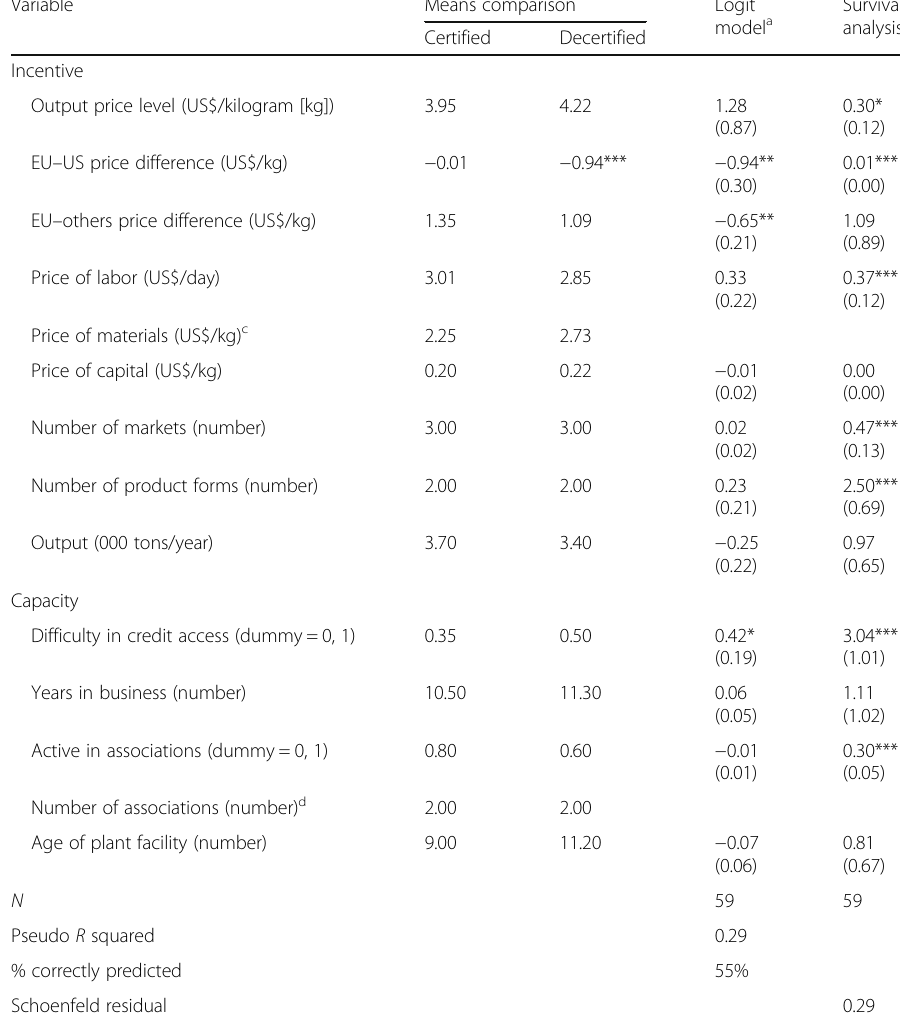
Table 5 Results of the means comparison, logit, and survival analyses to explain